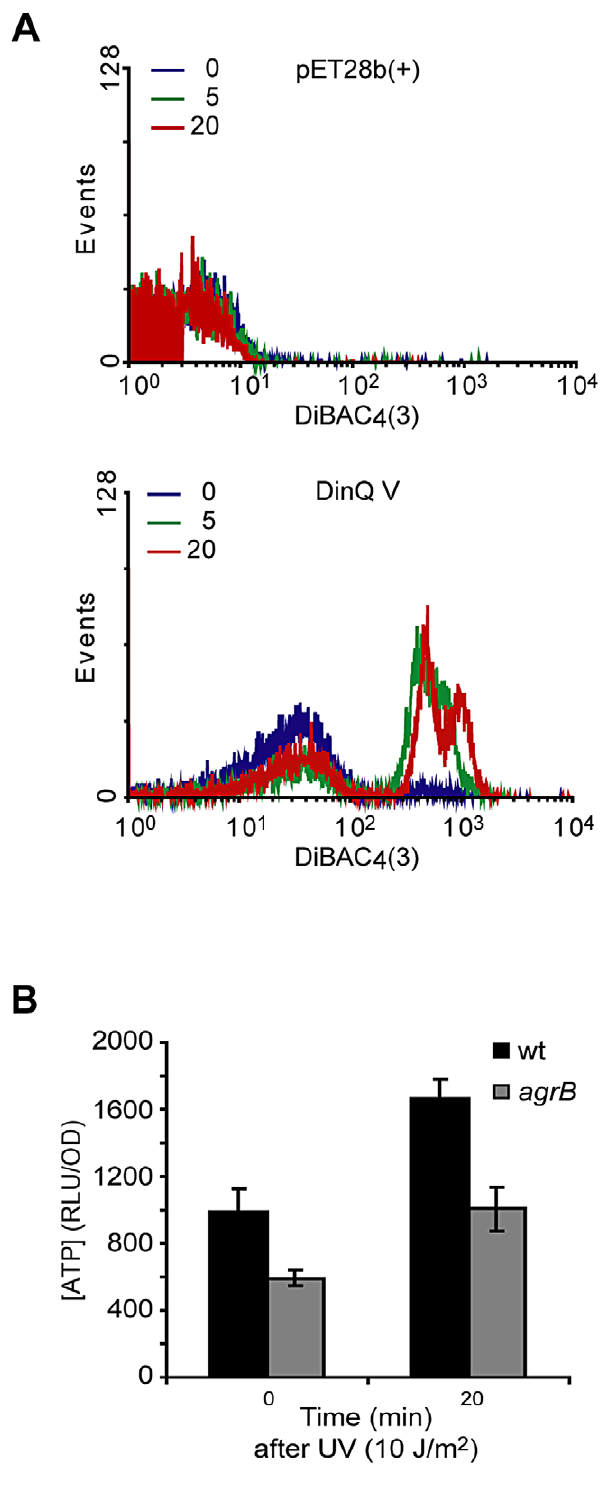
Figure 5. Effects of DinQ on membrane potential and intracellular ATP. (A) Exponentially growing cells were exposed to IPTG for 0, 5 and 20 min followed by measurement of DiBAC 4 (3) fluorescence. An increase in fluorescence intensity is observed as a consequence of membrane depolarization. Upper panel displays wt (ER2566) cells carrying expression vector pET28b( + ). Lower panel displays wt (ER2566) cells overexpressing DinQ V (pET28b( + )-DinQ V). The graphs are representative of at least three repetitions. (B) The staple diagram shows in vivo levels of ATP before and 20 min after